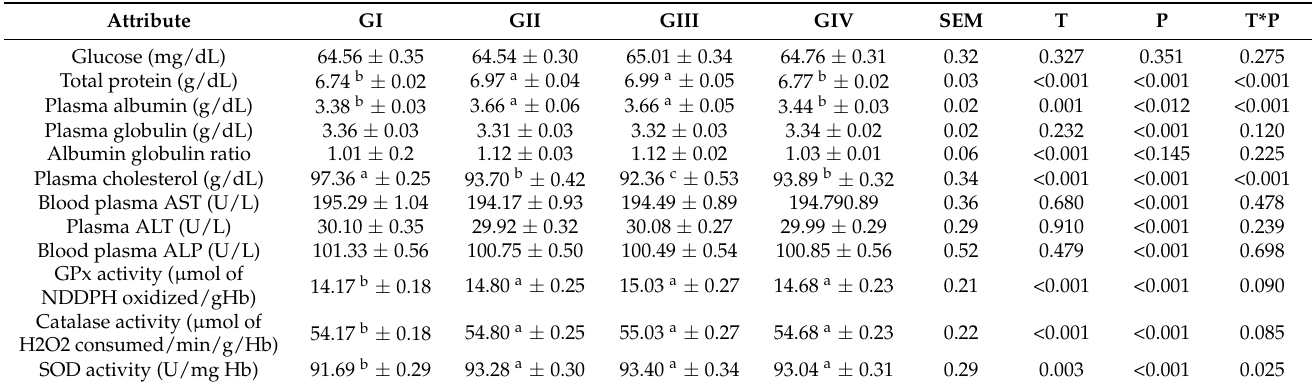
Table 7. Effects of replacement of concentrate with Moringa oleifera leaves on blood biochemical parameters, enzymes, and antioxidant activity of goat kids.